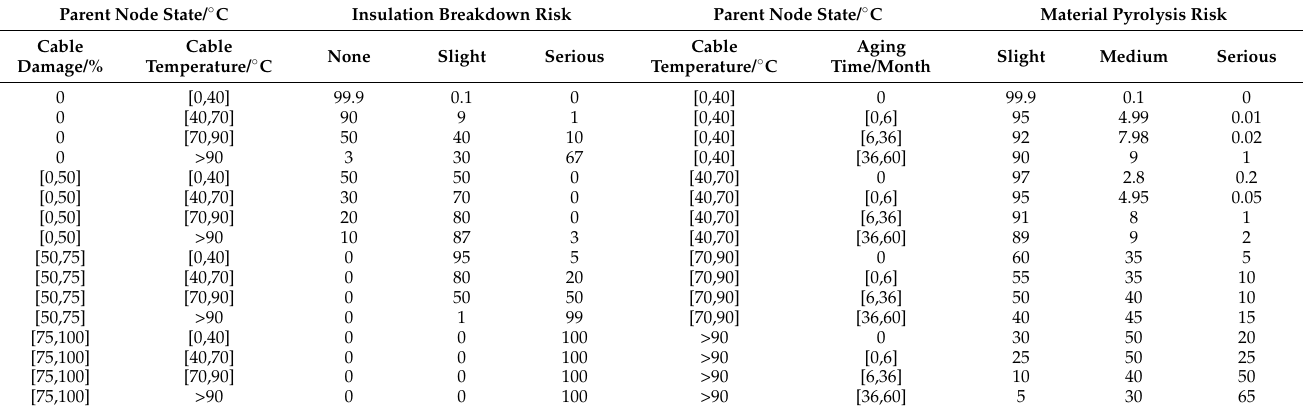
Table 4. Conditional probabilities of insulation breakdown risk and material pyrolysis